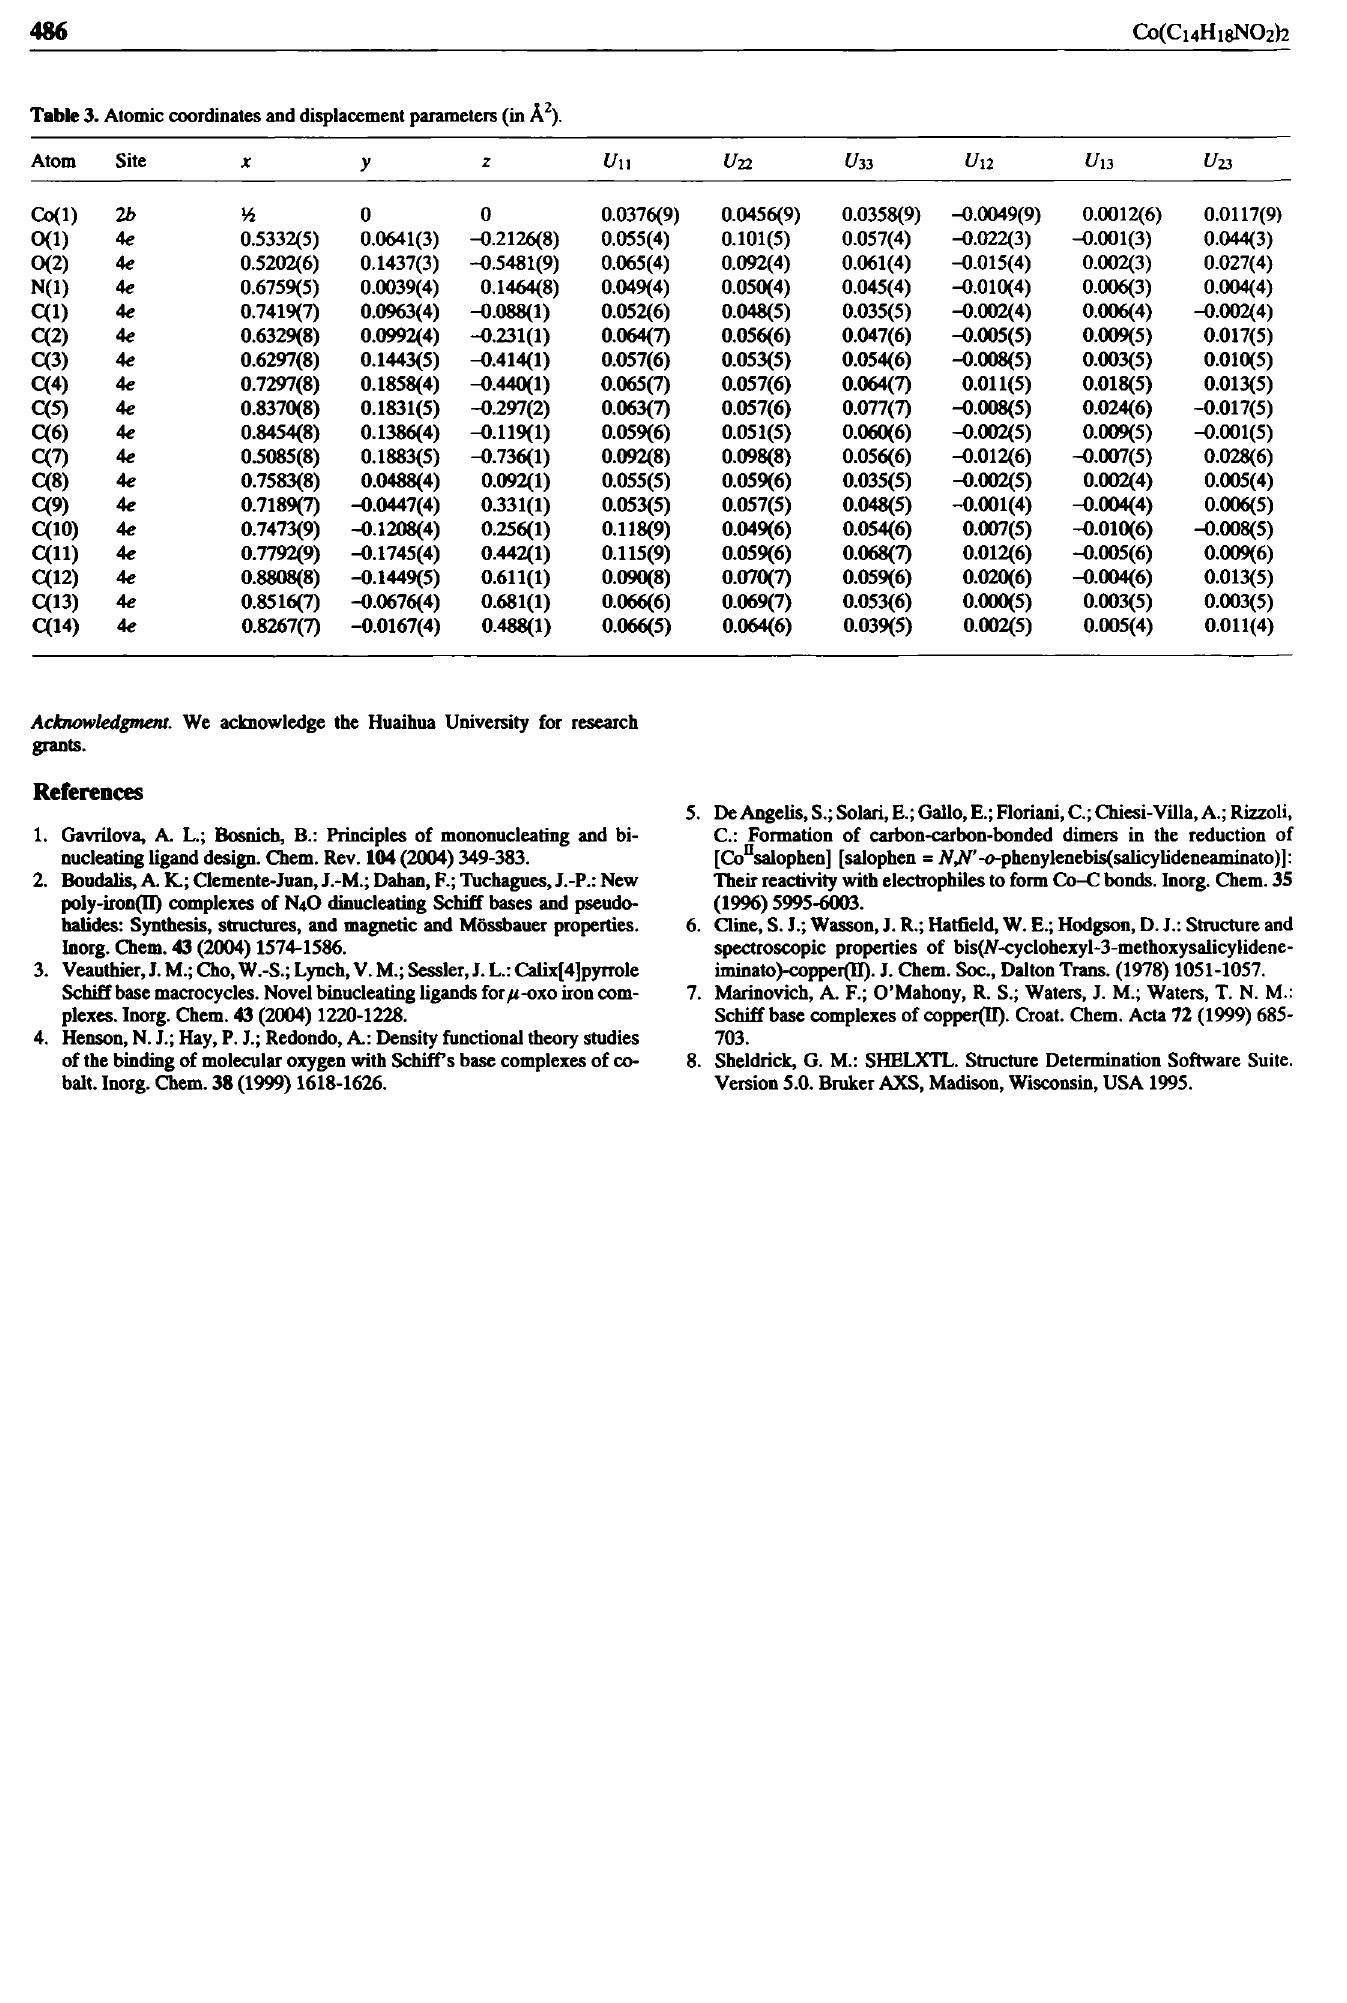
Table 3. Atomic coordinates and displacement parameters (in A 2